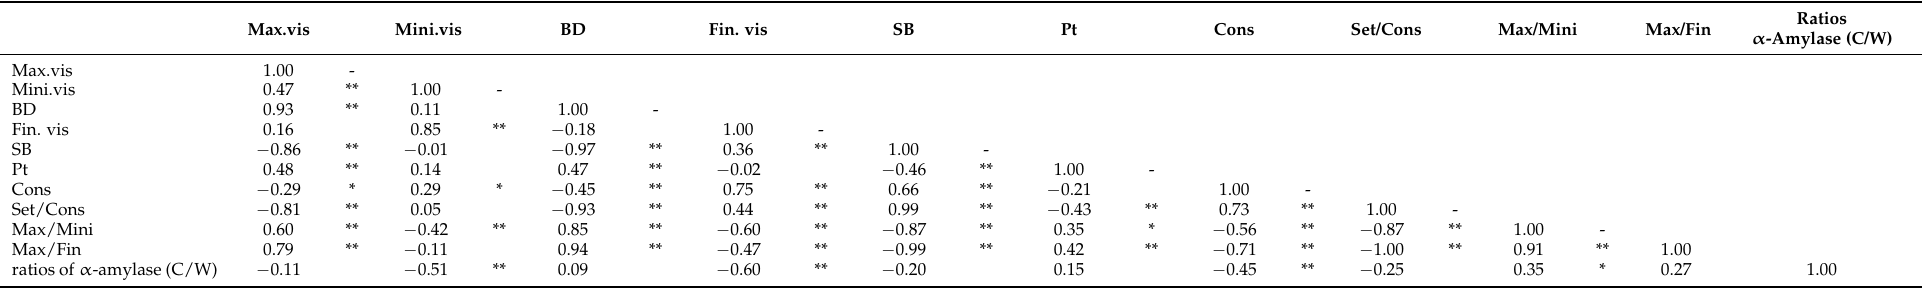
Table 3. Correlation between the ratios of α -amylase activities of chalky unpolished grains to those of whole ones and pasting properties in original 50 Japonica rice except low-amylose Japonica